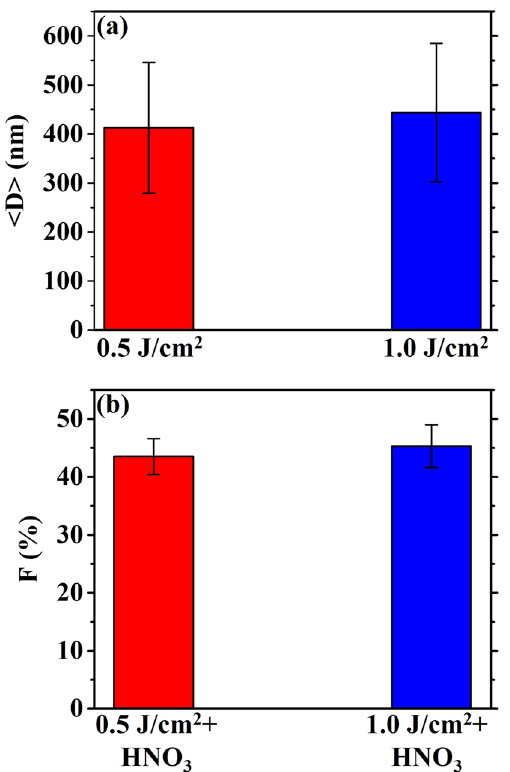
Figure 4. ( a ) Plot summarizing the measured average diameter < D > for the AuAg alloy particles obtained by the laser irradiation at 0.5 J/cm 2 and 1.0 J/cm 2 . ( b ) Plot summarizing the measured porosity fraction F (expressed as %) for the nanoporous Au particles obtained by the laser irradiation at 0.5 J/cm 2 and 1.0 J/cm 2 of the AuAg bilayer and followed by the Ag removal by HNO 3